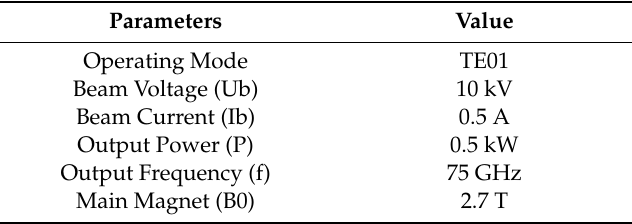
Table 2. Basic specifications of low-voltage